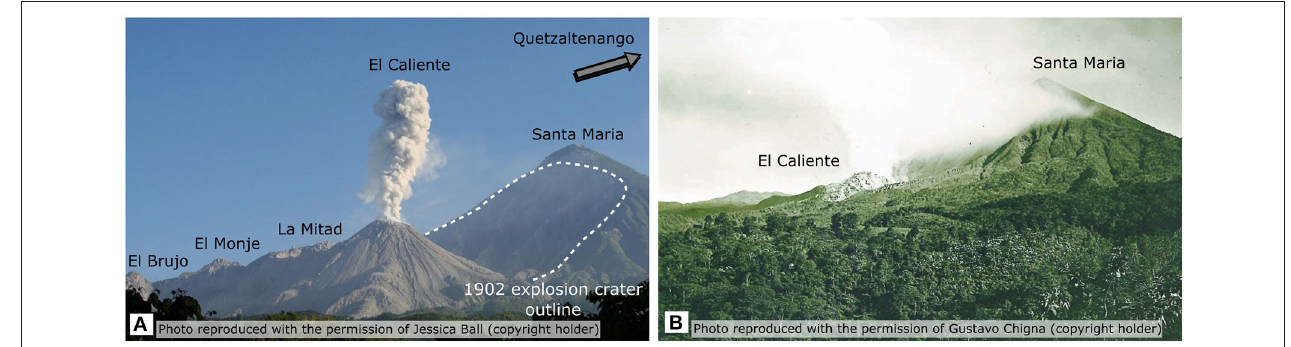
FIGURE 1 | (A) Photo of Santiaguito and Santa Maria from the south, showing a typical eruption from El Caliente. The four different domes are labeled. Quetzaltenango is Guatemala’s second largest city and is located 10km north. Photo from Jessica Ball. (B) Photo from a similar location in 1922, the first year of extrusion at El Caliente Dome inside the Santa Maria explosion crater. Photo source unknown,